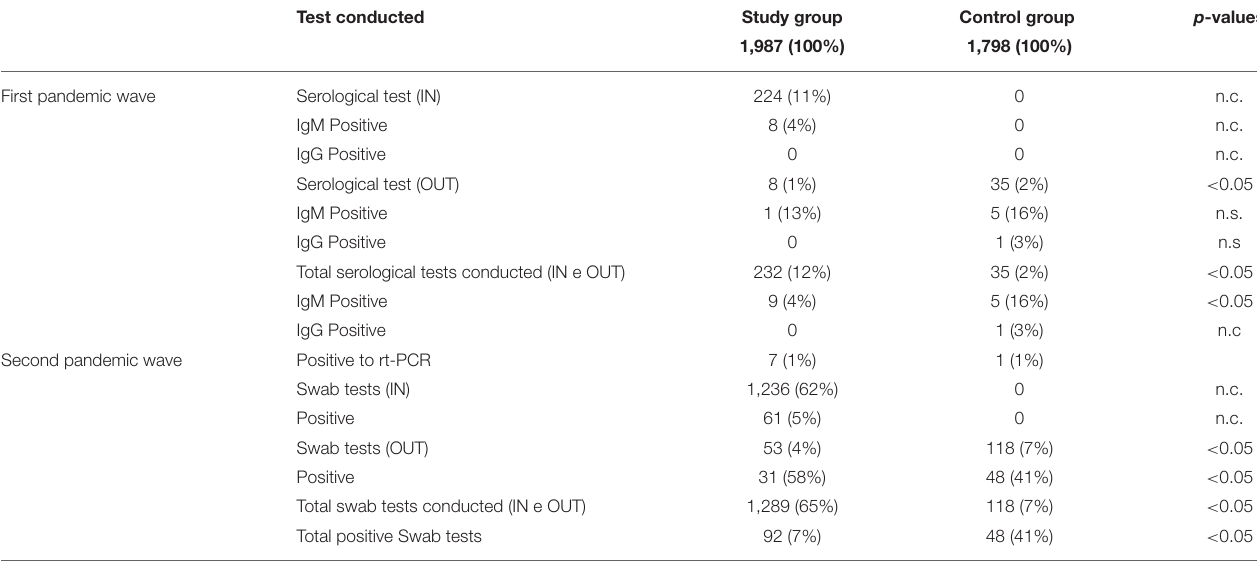
TABLE 3 | Results of the tests carried out between the study group and the control group during the first and second pandemic waves.